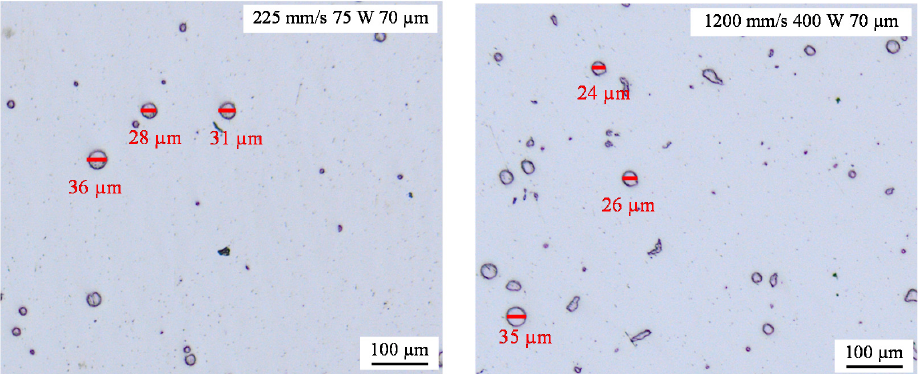
Figure 5. Polished microsection of W 45 samples with 225 mm/s scan speed and 1200 mm/s scan speed showing approximately equal particle size distributions.